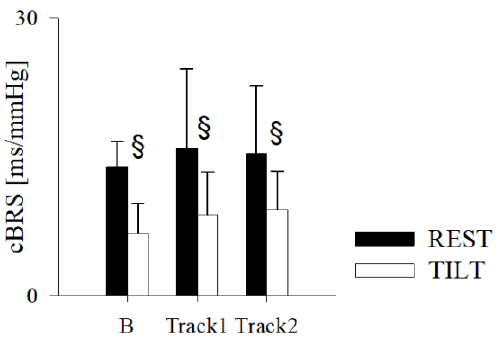
Figure 5. Results of the cardiac baroreflex sensitivity (cBRS) estimation in the healthy subjects while supine (REST) and during 70° head-up tilt test (TILT) in normal condition (B) and while listening to activating (Track1) and relaxing (Track2) algorithmic music. Data are expressed as mean ± standard deviation. § indicates p < 0.05 REST vs. TILT.